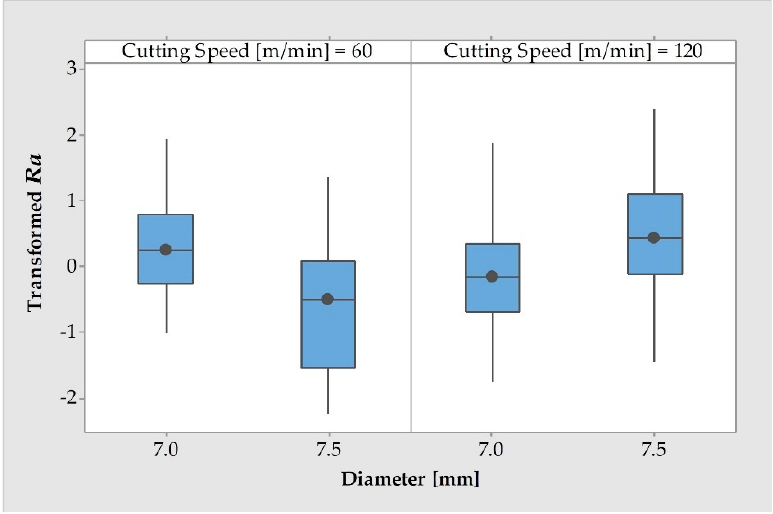
Figure 8. Box and whiskers plot graph for interactions between cutting speed and diameter, S*D .